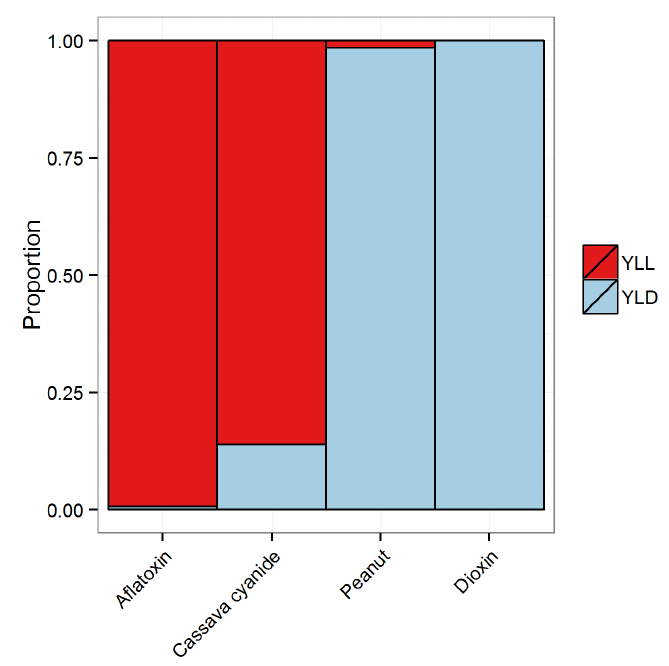
Figure 2. The relative contributions from YLLs and YLDs for each of four